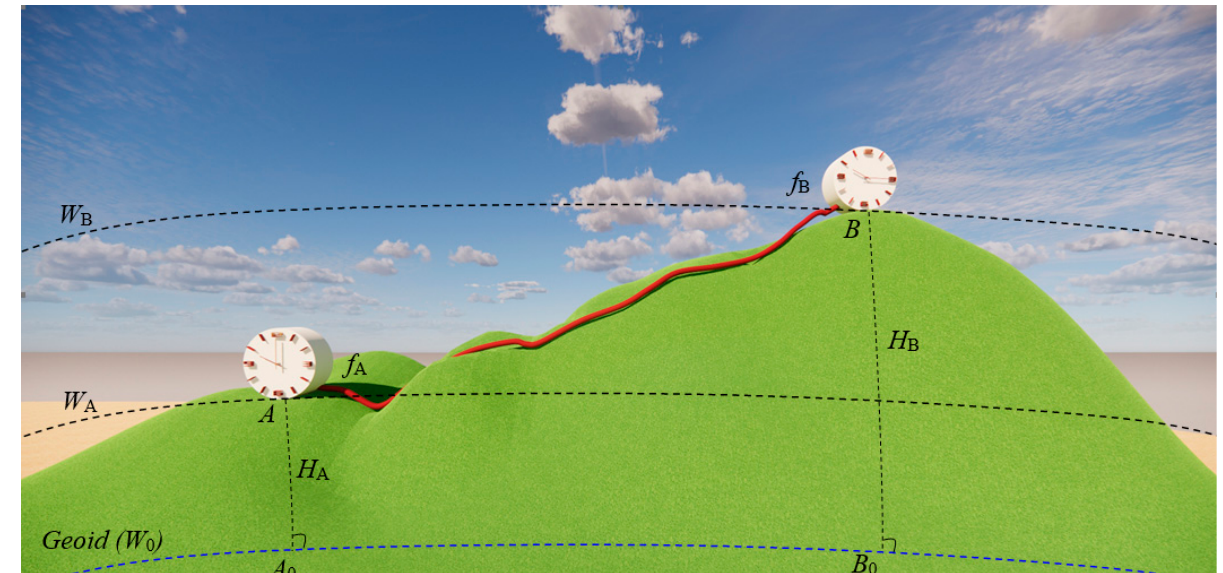
Figure 1. Determination of the geopotential difference by comparing optical clock frequency signals via optical fiber frequency transfer (OFFT) technique. The black dashed lines are equipotential surfaces passing through points A and B ; the blue dashed line is the geoid. A 0 and B 0 are the intersection points of plumb lines passing through A , B , and the geoid, respectively; H A and H B are the orthometric heights of points A and B ; W A , W B , and W 0 are geopotential at points A , B , and on the geoid, respectively; f A is the frequency transmitted from an optical clock at point A , f B is the frequency obtained by an optical clock at point B .